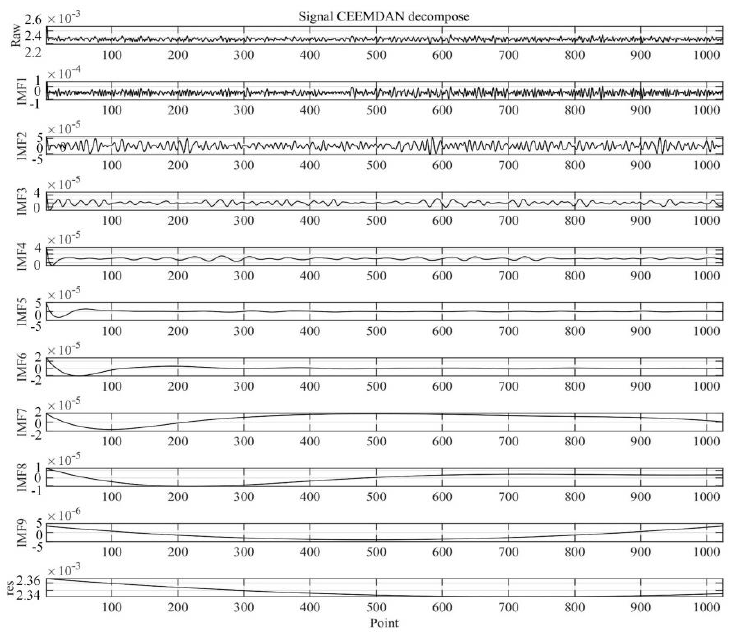
Figure 5. CEEMDAN decomposition of vibration signal.